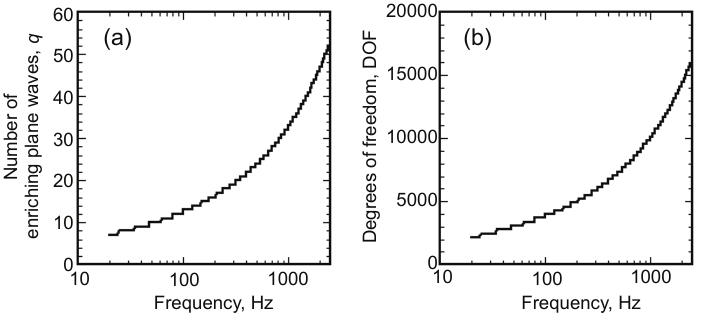
Figure 5. Changes in ( a ) the enriched plane waves number q and ( b ) DOF when using Mesh 2 with C =